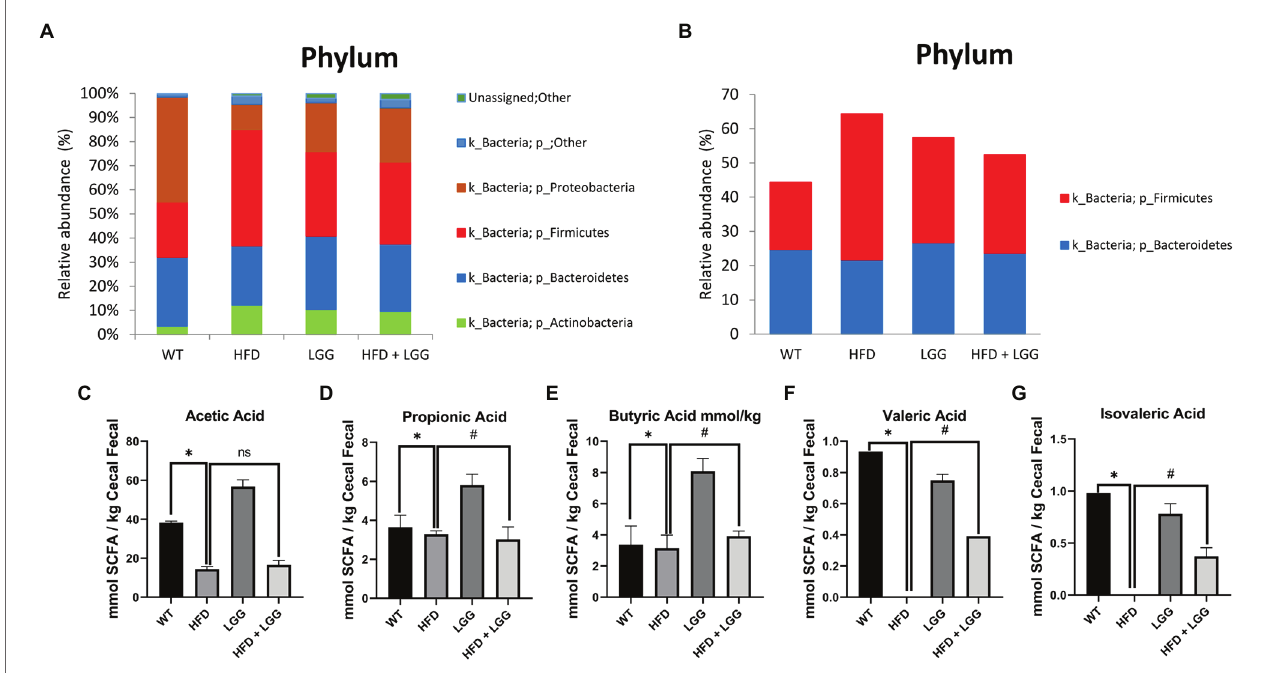
FIGURE 3 | Microbiota analysis of stool in all examined groups. WT, Wild-type C57BJ/L6 mice; HFD, HFD-supplemented wild-type mice; LGG, LGG-supplemented wild-type mice; HFD + LGG, HFD and LGG-supplemented wild-type mice. (A) Relative abundance of total bacteria at the phylum level in each treatment group (%); (B) Relative abundance of Bacteroides and Firmicutes at the phylum level in each treatment group (%); (C) Analysis of acetic acid; (D) Analysis of propionic acid; (E) Analysis of butyrate acid; (F) Analysis of valeric acid; (G) Analysis of isovaleric acid. All data represent means ± SD, WT vs. HFD group * p < 0.05; HFD vs. HFD + LGG ns p > 0.05, HFD vs. HFD + LGG # p < 0.05, n =